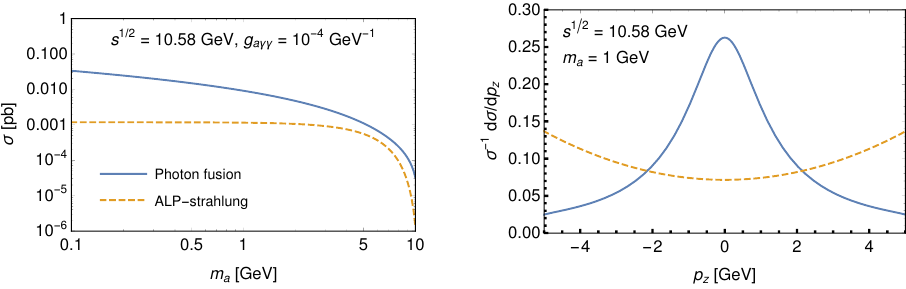
Figure 8 . Comparison of ALP production in e + e (cid:0) collisions via ALP-strahlung and via photon fusion. The left panel shows the total cross section, the right panel the di(cid:11)erential cross section with respect to the longitudinal momentum p z